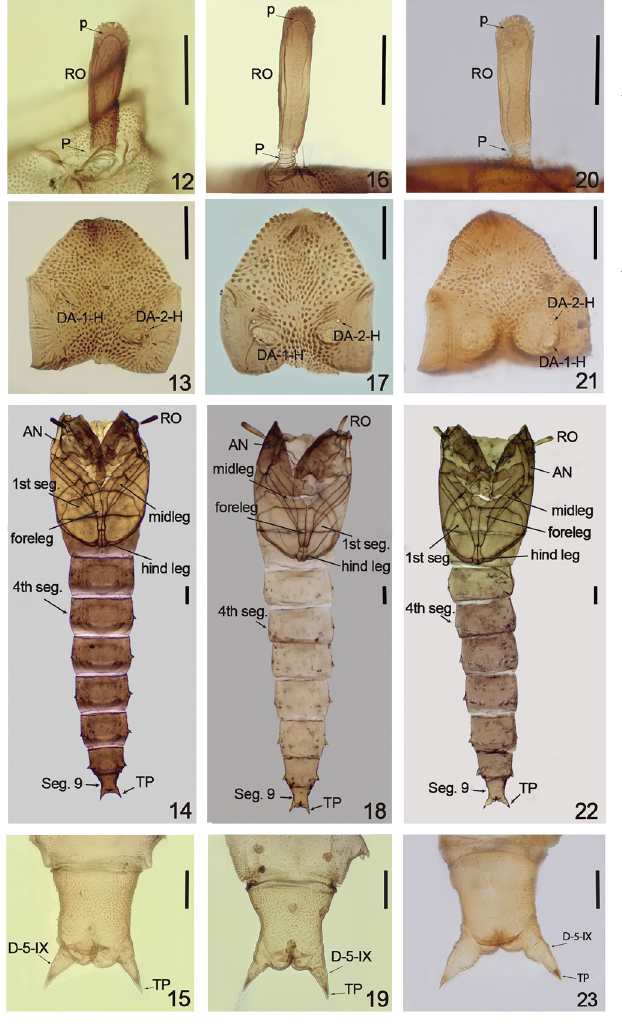
(Figs. 14, 39): D-2-IV, D-3-IV medium-sized, thin seta, D-4-IV, D-7-IV campaniform sensilla, D-5- IV short, stout seta, D-8-IV medium-sized, stout seta, D-9-IV long, thin seta; L-1-IV, L-2-IV, L-4-IV medium-sized, stout setae, L-3-IV long, thin seta, all on small or medium-sized tubercles;